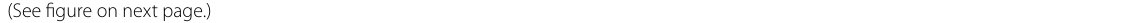
cohort(See figure on next Fig. 1 ERBB4 mutation are tightly associated with the prognosis of NSCLC. AI The prevalence of ERBB4 and TP53 mutations in NSCLC patients based on the cBioPortal for Cancer Genomics; AII The whole protein and specific changes of ERBB4 in the cohorts. B The relationship between ERBB4 mutation status and progress free survival (PFS) of NSCLC patients treated by ICIs; C The relationship between ERBB4 mutation status and overall survival (OS) of NSCLC patients treated by ICIs. D The relationship between ERBB4 mutation status and OS of LUAD patients treated by non-ICIs from the TCGA cohort. E The relationship between ERBB4 mutation status and OS of LUSC patients treated by non-ICIs from the TCGA